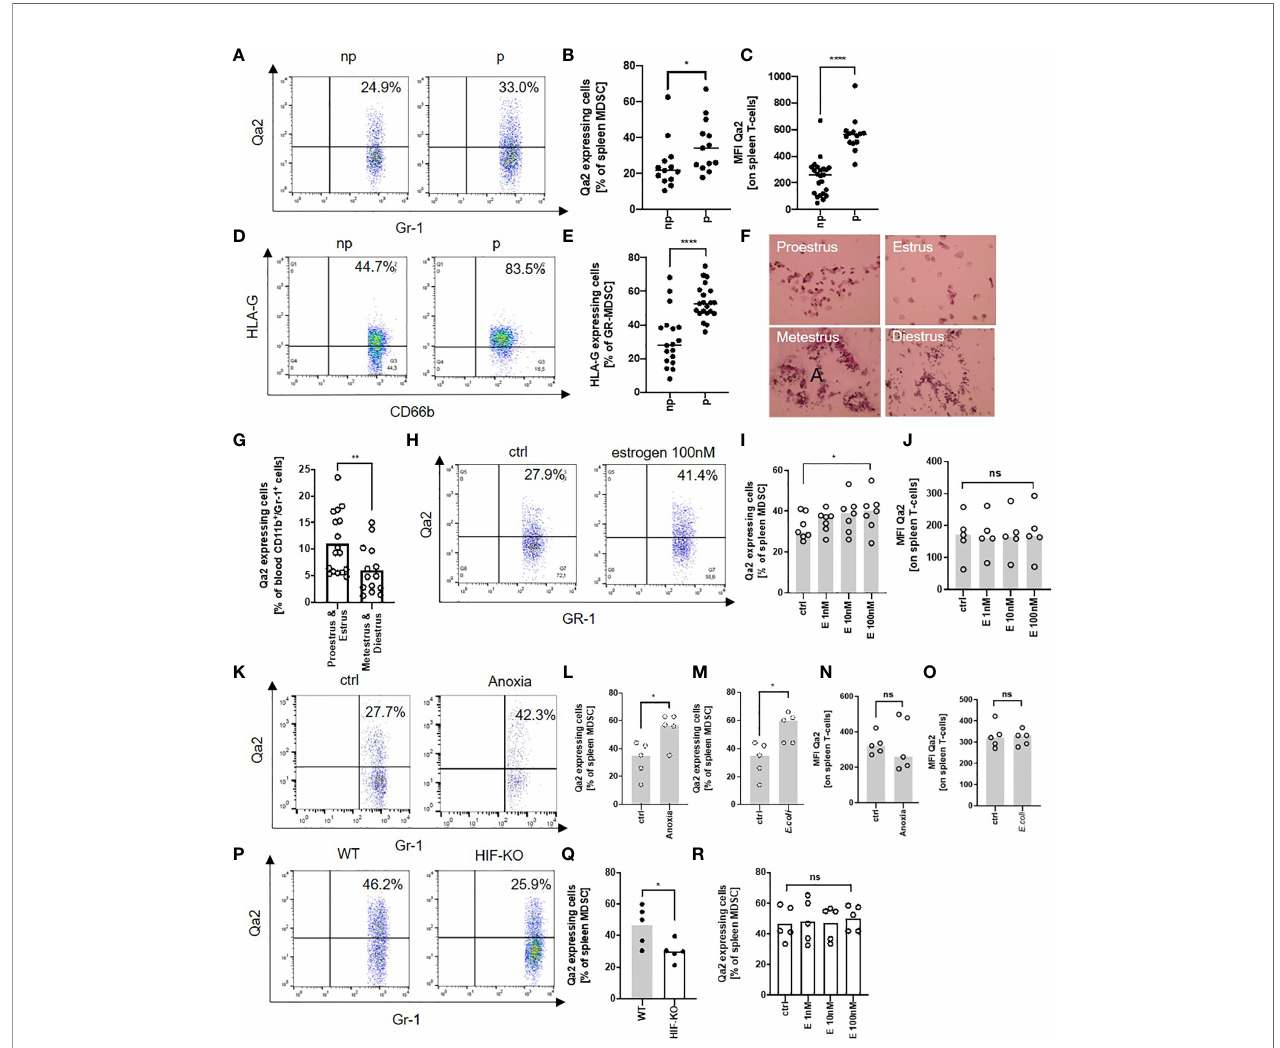
FIGURE 4 | Expression of Qa-2 on MDSC is regulated by estrogen via HIF-1 a . (A) Representative pseudocolor plots for Gr-1 versus Qa-2 from splenocytes from non-pregnant (np) and pregnant (p) wildtype (WT) animals showing the percentage of Qa-2 expressing MDSC in the upper right quadrant. Cells were pre-gated on CD45 and CD11b. (B) Percentages of Qa-2 expressing MDSC from all spleen MDSC from non-pregnant (n=13) and pregnant WT mice (n=13). (C) MFI for Qa-2 on spleen T-cells from non-pregnant (n=23) and pregnant WT mice (n=14). (D) Representative pseudocolor plots for CD66b versus HLA-G from PBMC from non- pregnant (np) and pregnant (p) women showing the percentage of HLA-G expressing MDSC in the upper right quadrant. (E) Percentages of HLA-G expressing MDSC from all MDSC in the peripheral blood of non-pregnant (n=18) and pregnant women (n=21). (F) Representative images of H&E stained vaginal swabs from the four different phases of the mouse estrus cycle. (G) Percentages of Qa-2 expressing cells from all blood CD11b + /Gr-1 + cells in proestrus & estrus (n=14) and metestrus & diestrus (n=17). (H) Representative pseudocolor plots for Gr-1 versus Qa-2 from splenocytes from WT mice without stimulation (ctrl) and with stimulation with 100nM estrogen showing the percentage of Qa-2 expressing MDSC in the upper right quadrant. Cells were pre-gated on CD45 and CD11b. (I) Percentages of Qa-2 expressing MDSC from all spleen MDSC from WT mice without stimulation and with stimulation with estrogen in rising concentrations (n=7). (J) MFI for Qa-2 on spleen T-cells from wildtype mice without stimulation and with stimulation with estrogen in rising concentrations (n=5). (K) Representative pseudocolor plots for Gr-1 versus Qa-2 from splenocytes from wildtype (WT) mice cultured under normoxia (ctrl) or anoxia for 4 h showing the percentage of Qa-2 expressing MDSC in the upper right quadrant. Cells were pre-gated on CD45 and CD11b. (L) Percentages of Qa-2 expressing MDSC from all spleen MDSC from WT mice cultured under normoxia or anoxia (n=5). (M) Percentages of Qa-2 expressing MDSC from all spleen MDSC from WT mice without stimulation or with stimulation with (E) coli (n=5). (N) MFI of Qa-2 on spleen T-cells from WT mice cultured under normoxia or anoxia (n=5). (O) MFI of Qa-2 on spleen T-cells from wildtype mice without stimulation or with stimulation with (E) coli (n=5). (P) Representative pseudocolor plots for Gr-1 versus Qa-2 from splenocytes from pregnant WT animals and pregnant animals with targeted deletion of HIF-1 a in myeloid cells (HIF-KO) showing the percentage of Qa-2 expressing MDSC in the upper right quadrant. Cells were pre-gated on CD45 and CD11b. (Q) Percentages of Qa-2 expressing MDSC from all spleen MDSC from WT mice (n=5) and from HIF-KO mice (n=5). (R) Percentages of Qa-2 expressing MDSC from all spleen MDSC from HIF-KO mice without stimulation and with stimulation with estrogen in rising concentrations (n=5). Each symbol represents an individual animal/women and the mean is indicated. ****p < 0.0001; **p < 0.01; *p < 0.05; ns, not signi fi cant. Mann-Whitney test (B, C, E, G, Q) and Wilcoxon matched-pairs signed rank test (I, J, L – O, R)